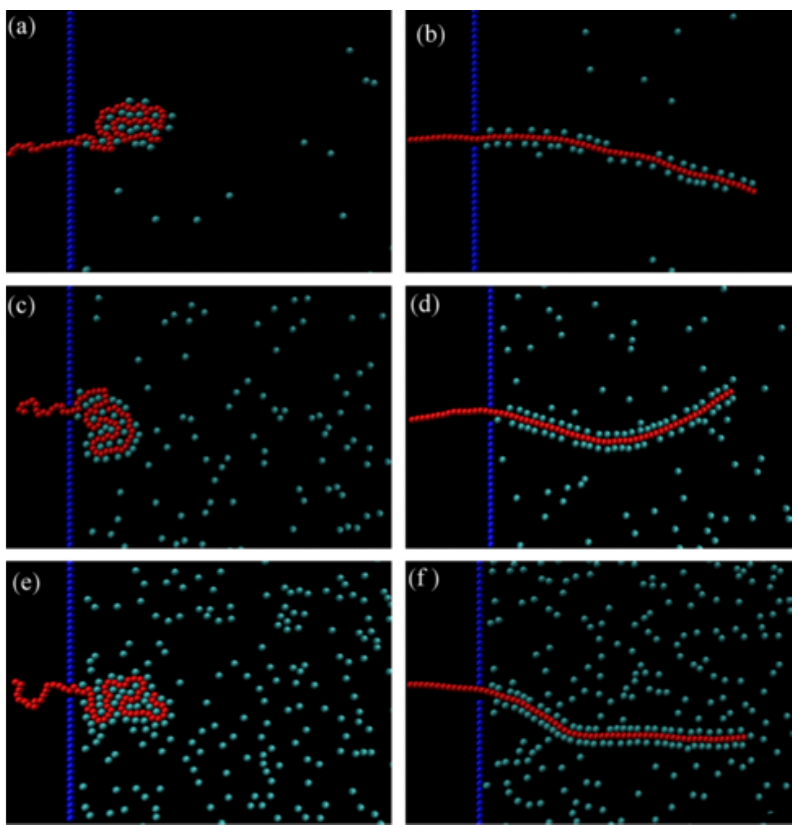
Figure 9. Translocation in the presence of chaperons, where the cyan circles represent the chaperons and the red circles represent the chain monomers. The left panel shows snapshots of the process for a fully flexible chain, whereas the right panel shows the same for a very stiff chain. The studies were performed using Brownian dynamic simulations for three chaperons densities for both chains. ( a , c , e ) correspond to three densities, ρ = 1%, 5%, and 10%, respectively, for a fully flexible chain, whereas ( b , d , f ) correspond to a stiff chain ( κ = 256) for the same densities. This figure is reprinted with permission from [79]. Copyright 2015 by the American Physical